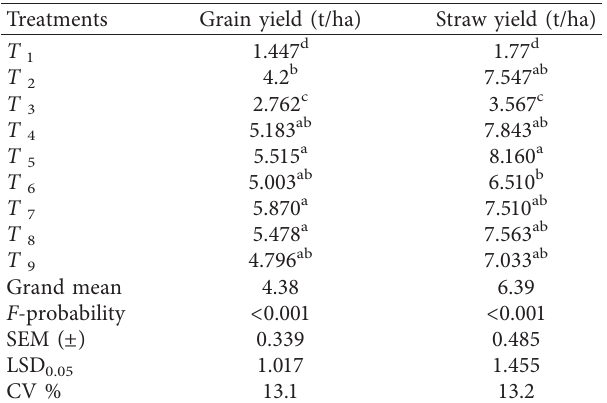
SEM � standard error of mean; CV � coefficient of variation. Means fol- lowed by difference letters are significantly different among each other on DMRT at a 5% level of